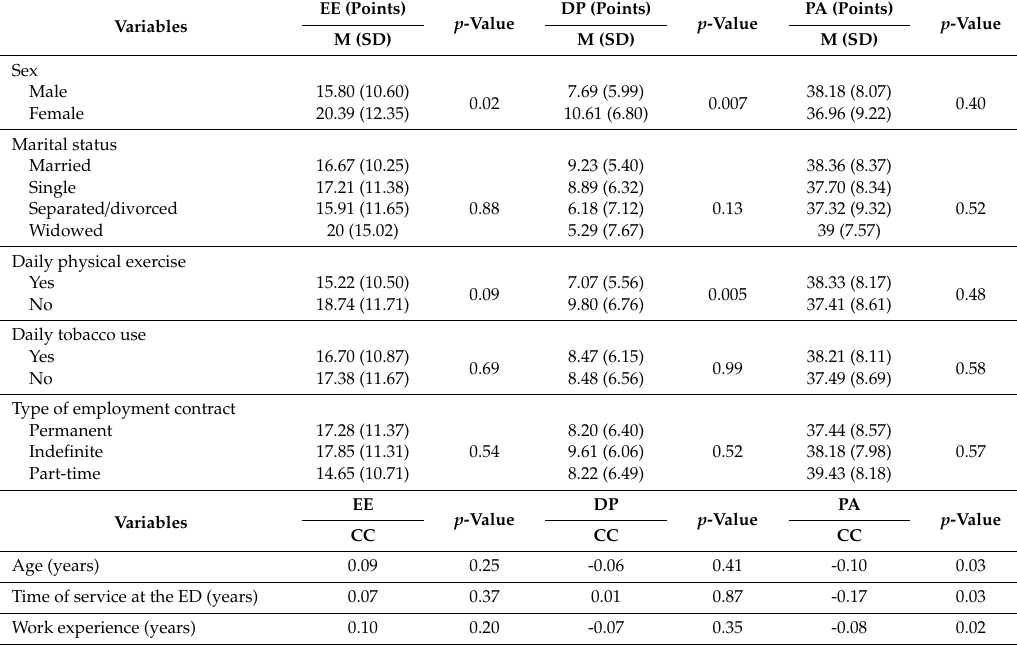
Table 3. Comparison of participants’ burnout and sociodemographic and occupational